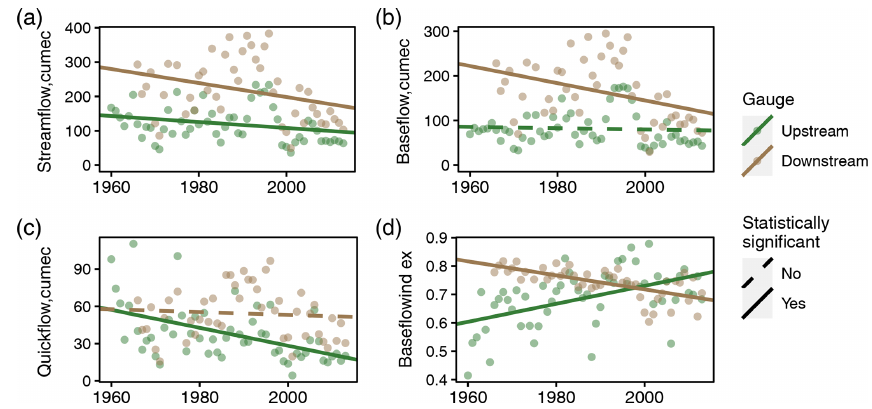
Figure 9. Long-term trends at Sangam station (upstream; gauge i) and Sopore station (downstream; gauge iv) of (a) streamflow, (b) baseflow, (c) quickflow, and (c) the baseflow index, which is the fraction of streamflow comprised of baseflow. The statistical significance in this analysis was associated with p < 0 . 1 for a nonzero trend from a linear, least-squares regression. All statistically significant trends were also significant for p < 0.05, except for the upstream trend in panel (a) .